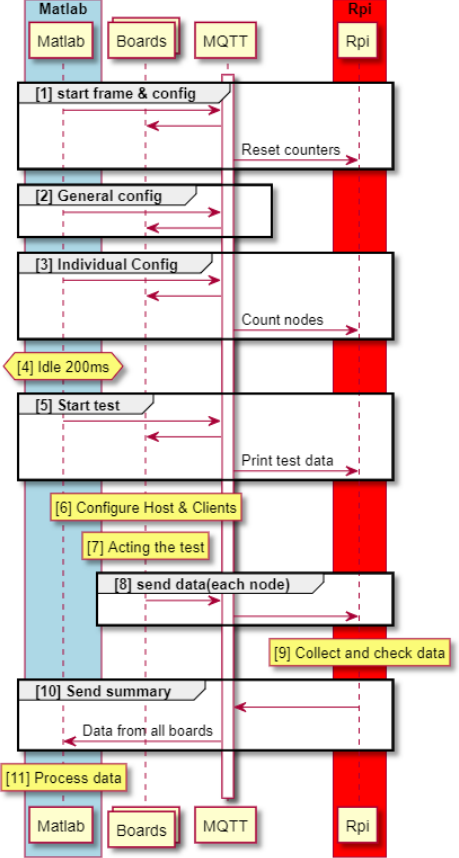
Figure 6. A data flow between research stand